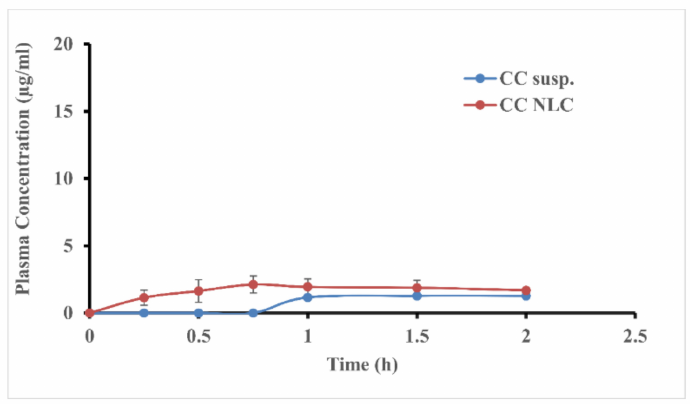
Figure 5. The average plasma concentration of candesartan in rats after intragastric administration of CC-NLC and CC suspension.